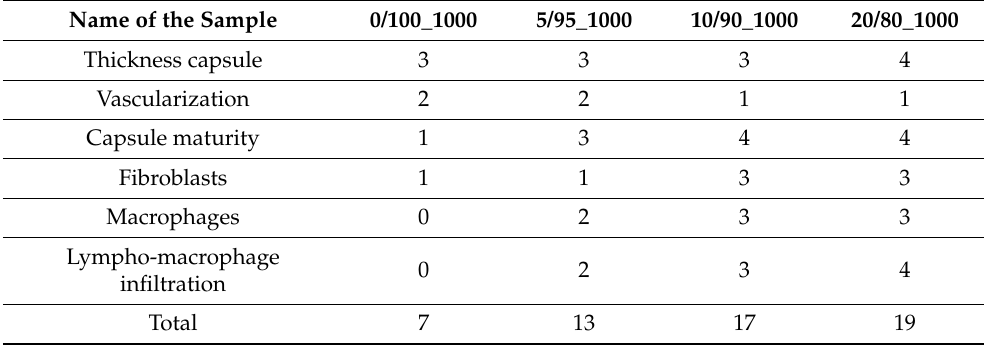
Figure 15. Images of the ceramic materials with a weight ratio of: ( a ) Ca(PO 3 ) 2 /Ca 2 P 2 O 7 = 0/100; ( b ) Ca(PO 3 ) 2 /Ca 2 P 2 O 7 = 5/95; ( c ) Ca(PO 3 ) 2 /Ca 2 P 2 O 7 = 10/90; ( d ) Ca(PO 3 ) 2 /Ca 2 P 2 O 7 = 20/80 at a temperature of 1000 °C after implantation.